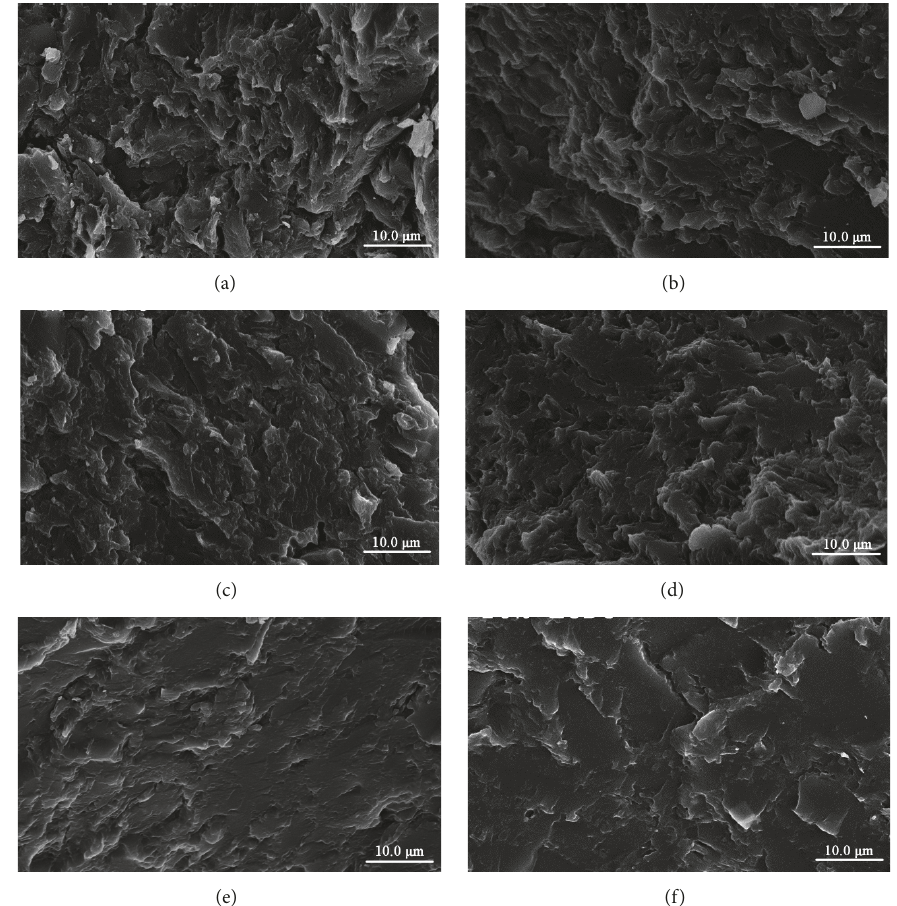
Figure 2: SEM micrographs of fracture surface of cured EGDE/SF adhesives.